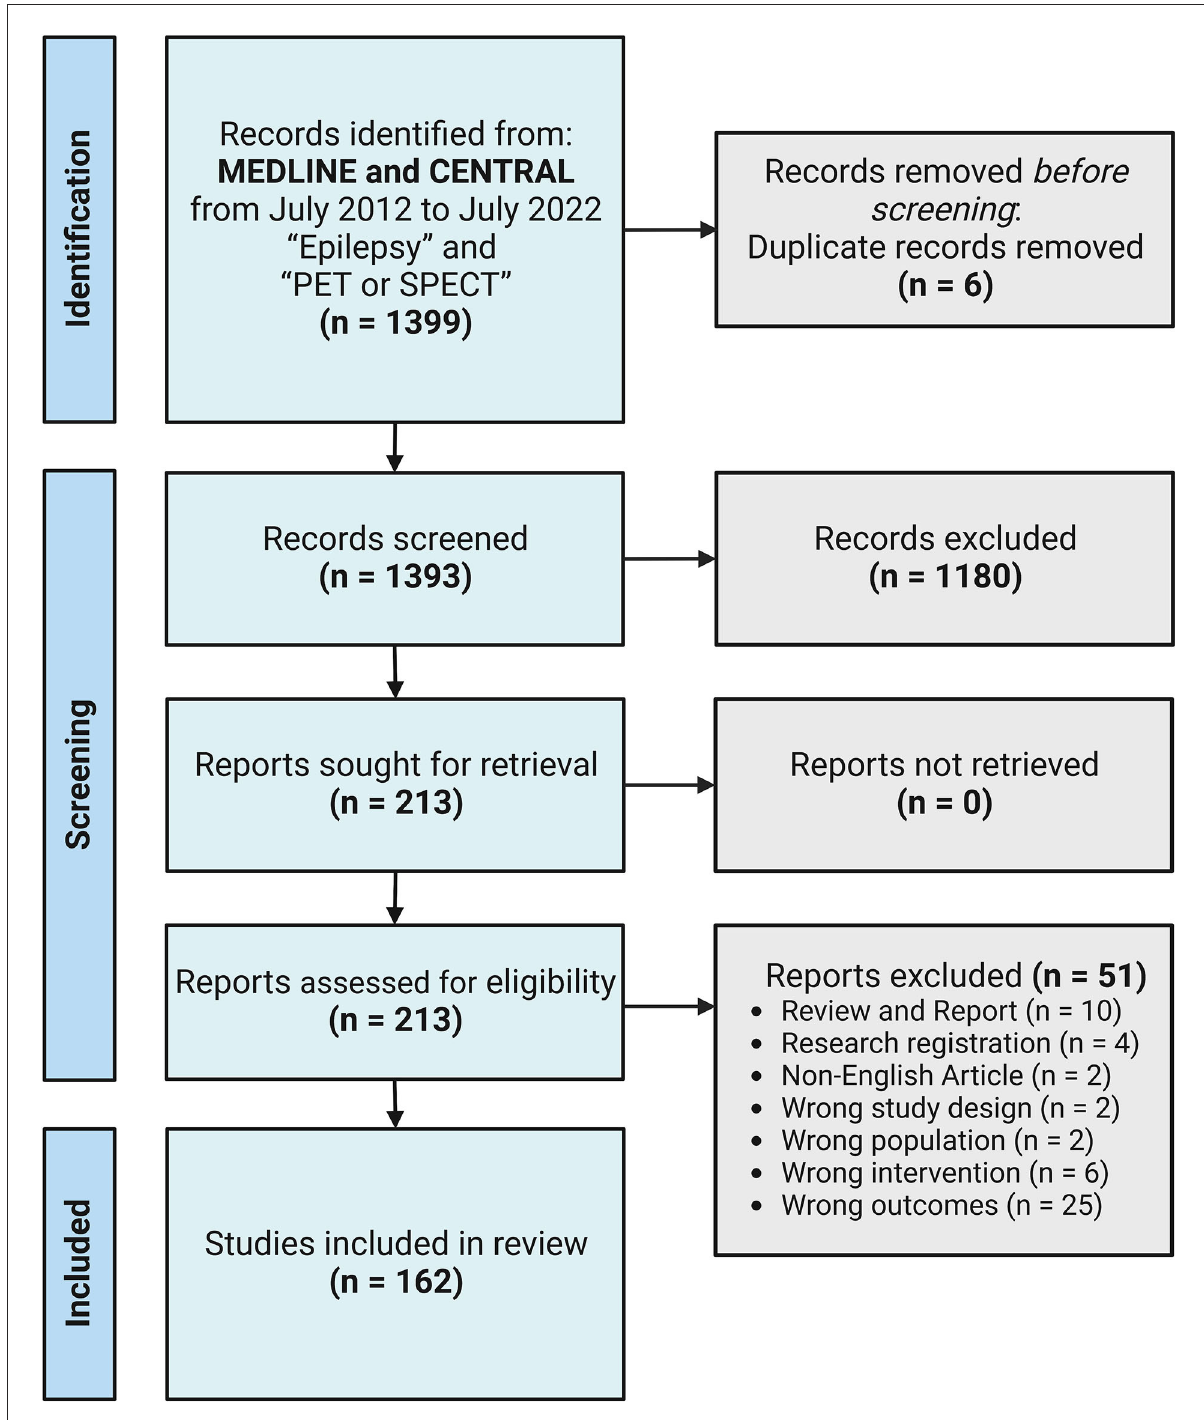
FIGURE1 PRISMA flow diagram for the study recruitment. A final 162 studies were